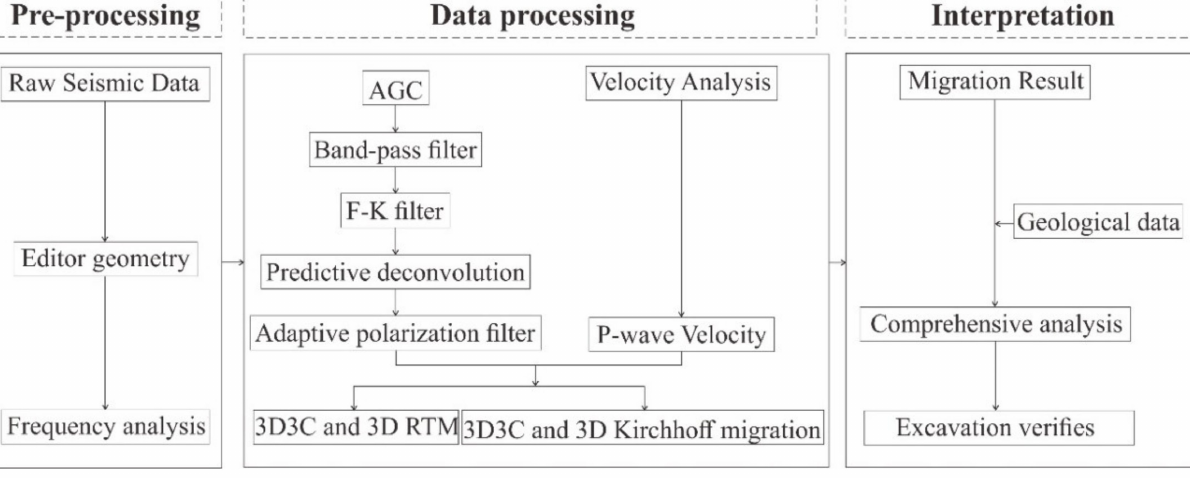
Figure 11. Flow chart of the seismic data processing. The 3D 3C and 3D RTM are 3-D multi-component P-wave RTM and single-component P-wave RTM, respectively. The 3D3C and 3D Kirchhoff migration are 3-D multi-component and single-component Kirchhoff migration,